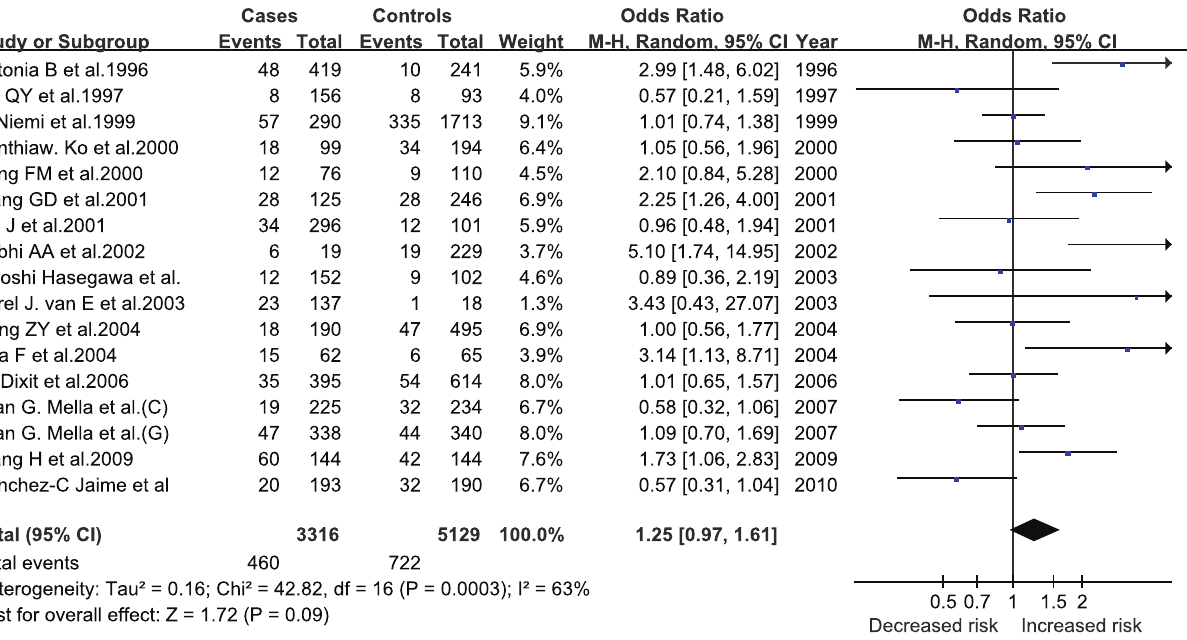
Figure 3. Pooled random-effects-based odds ratio of developing GSD for e 4 versus e 3.